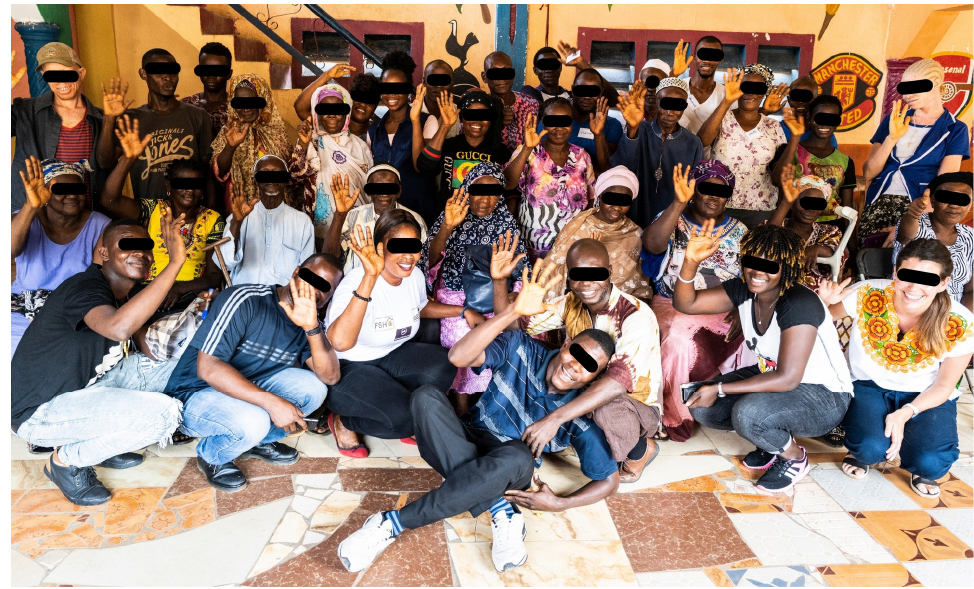
Figure 3. Dworzark Community, FEDURP data collectors and UCL research team after meeting together to talk about AT and disability issues the Community Center, November 2019. Credit: Angus